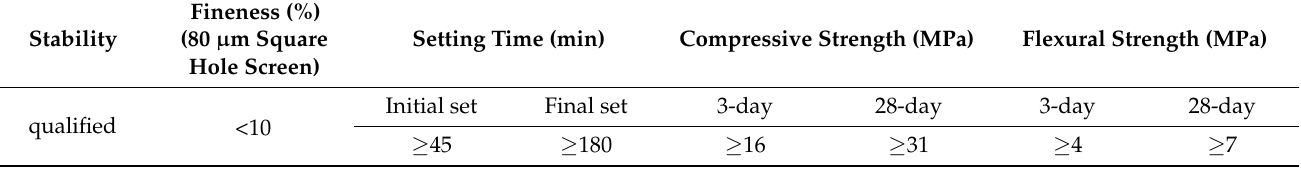
Table 1. Technical parameters of polyester fiber. Table 2. Technical parameters of cement.